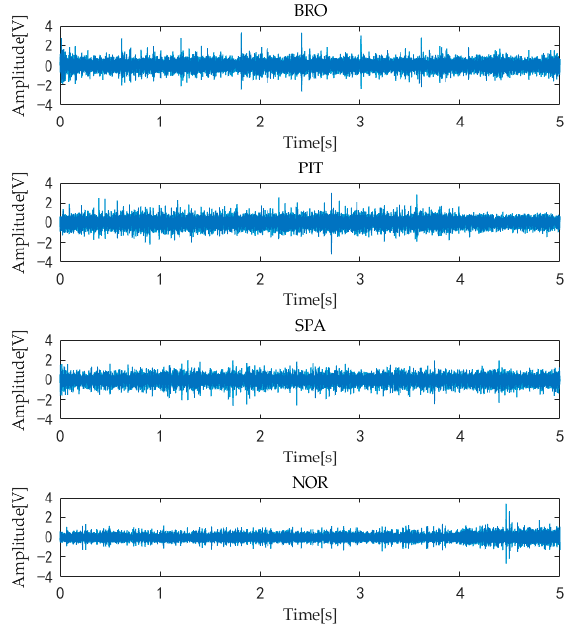
Figure 14. Original vibration signal time-domain waveforms of worm gear.